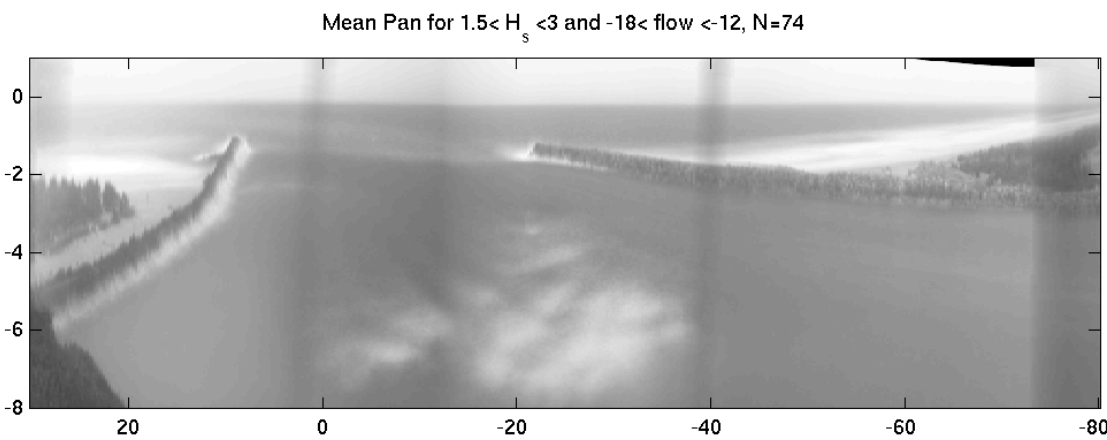
Figure 13. Bin-averaged “brightest” pan for wave heights between 1.5 and 3.0 m and spring ebb flows. The strong ebb flows cause breaking over Guano Rock (lower center of the image), as well as a slight increase in breaking at the mouth of the inlet.